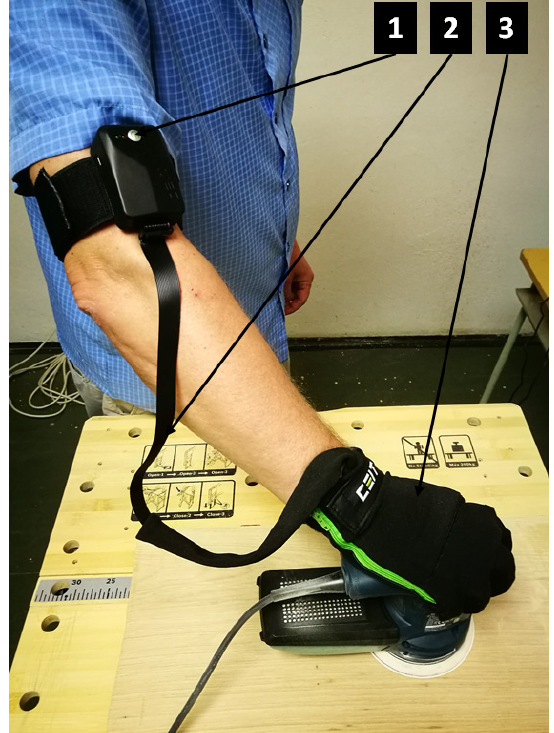
Figure 2. Compressive force monitoring system: 1—data box/Bluetooth transmitter, 2—data cable, 3—glove with pressure sensors.